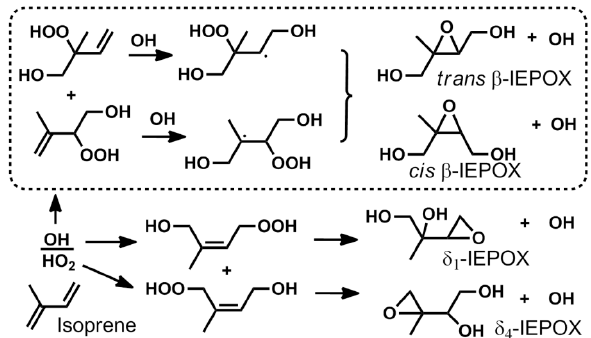
Scheme 1 Formation of IEPOX isomers, from relevant isoprene hydroxy hydroperoxide precursors, in the low-NO photooxidation of isoprene. The expected dominant pathway is shown inside the box. The naming convention is based on Paulot et al.